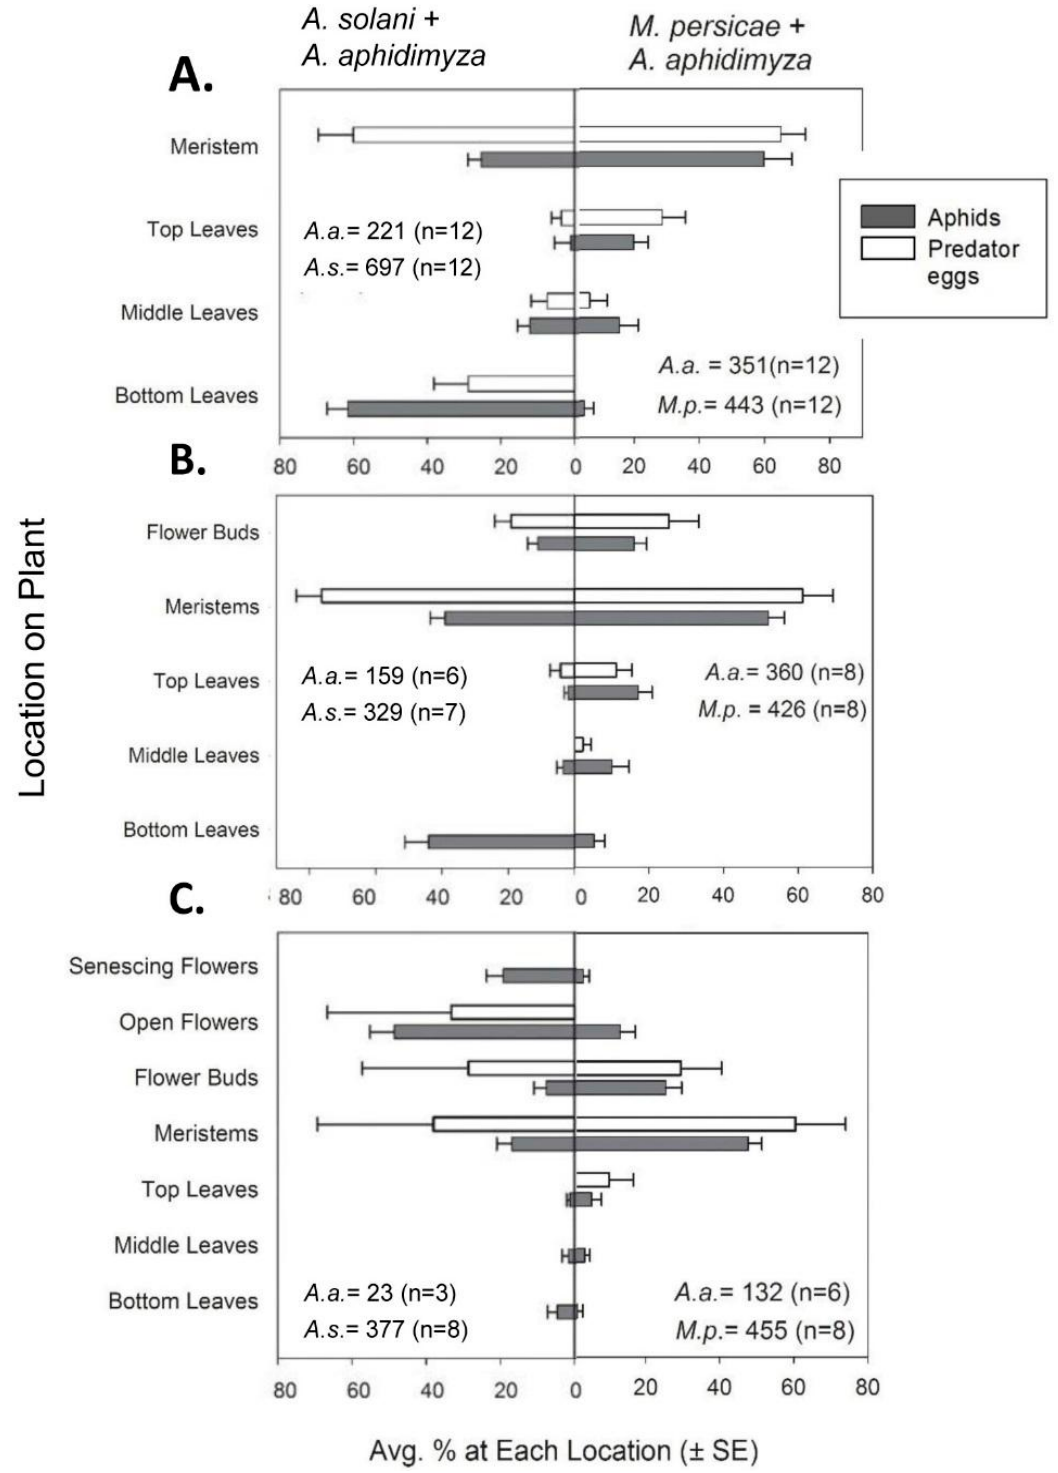
Figure 1. Plants were in the following stages of growth: ( A ) vegetative; ( B ) budding; and ( C ) flowering. Distribution (average % ± SE) of the total aphid population found at each location within plants are shown for Aulacorthum solani ( A.s .) and Myzus persicae ( M.p .) as black bars; proportion of total A. aphidimyza eggs deposited at each plant location is shown by the white bars. Total aphid and predator egg numbers for all samples are given. All results are from day 2 after release of 100 A. aphidimyza adults /compartment.